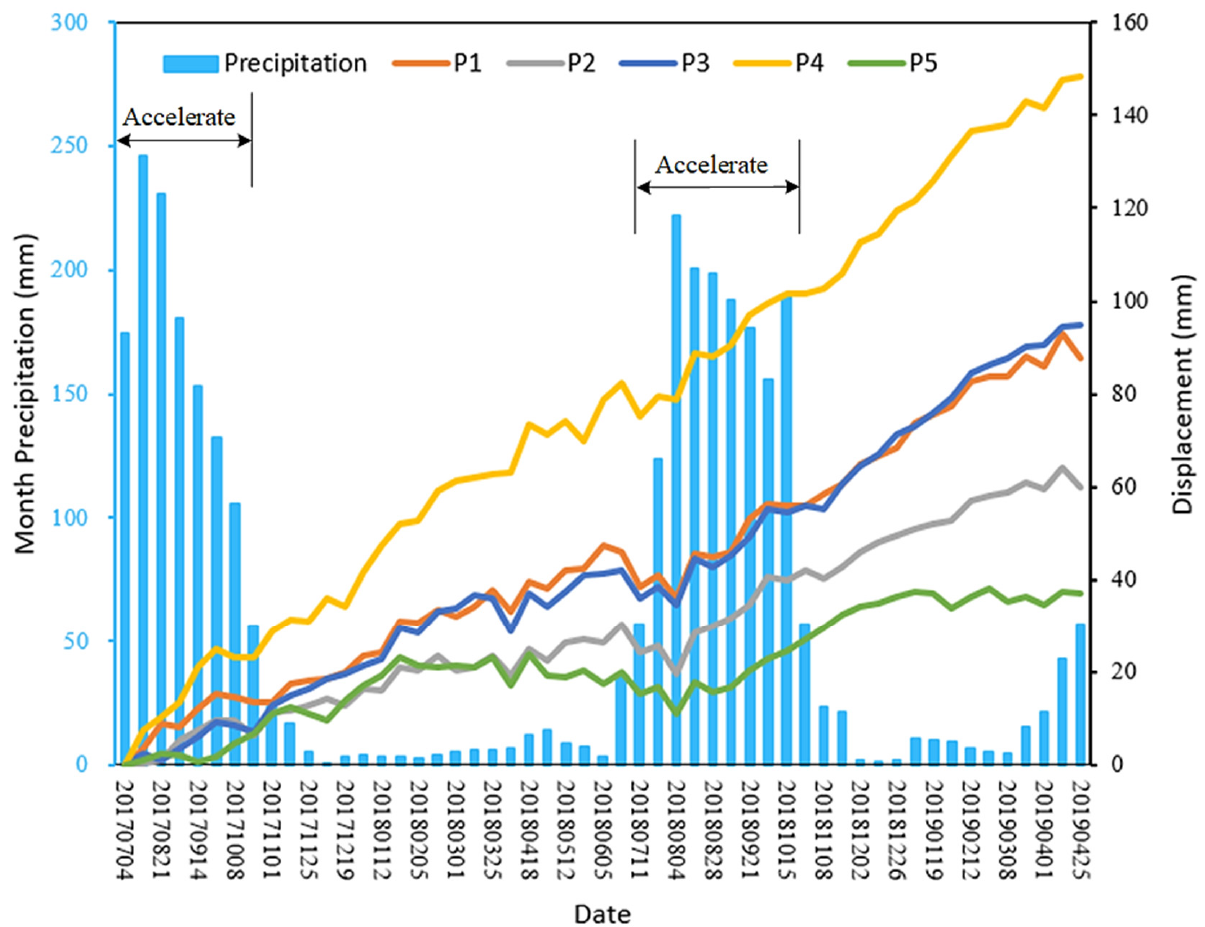
Figure 18. Time series displacement of XJ landslide monitoring sites with rainfall during July 2017– May 2019.